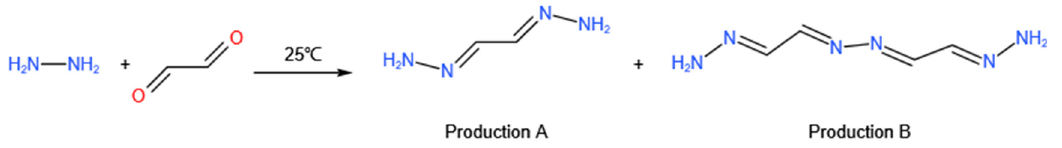
Figure 3. Synthesis route of hydrazone Schiff bases.